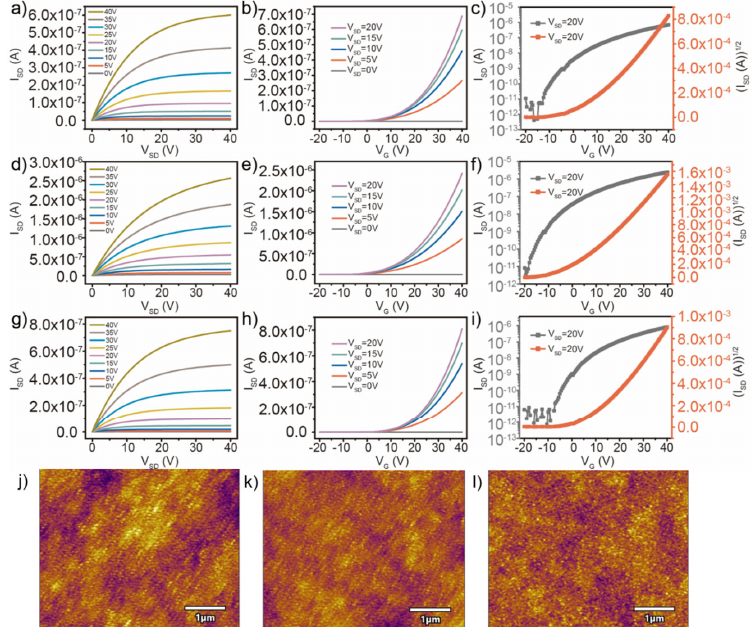
Figure 4. Output characteristics and transfer characteristics of TFTs with ZnO/AZO/SiO 2 /Si double ‐ active ‐ layers before ( a − c ) and after annealing in vacuum environment ( d − f ) and in air ( g − i ). Atomic force microscope images of the ZnO/AZO channel layers without ( j ) and with annealing treatment in vacuum environment ( k ) and in air ( l ). Table 1. The field ‐ effect parameters of the TFTs with various active layers and annealing atmos ‐ phere.